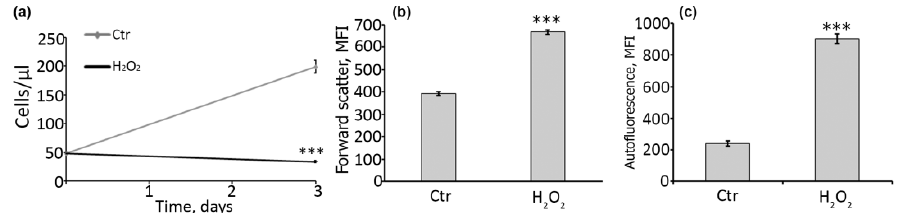
Figure 4. DFO-rescued hMESCs enter senescence-like state upon repeated oxidative stress. To test the stress reactions of H 2 O 2 -treated hMESCs that escaped senescence due to DFO pretreatment, such cells were seeded at equal density in 7 days after the initial treatment and either remained untreated (control cells) or were subjected to the repeated oxidative stress (200 µM of H 2 O 2 for 1h). Cells were cultivated for additional three days and analyzed by FACS. ( a ) Growth curves, ( b ) FSC (forward scattering), ( c ) AF (autofluorescence). Data are shown as Mean ± SD, n = 3, *** p ˂ 0.005.